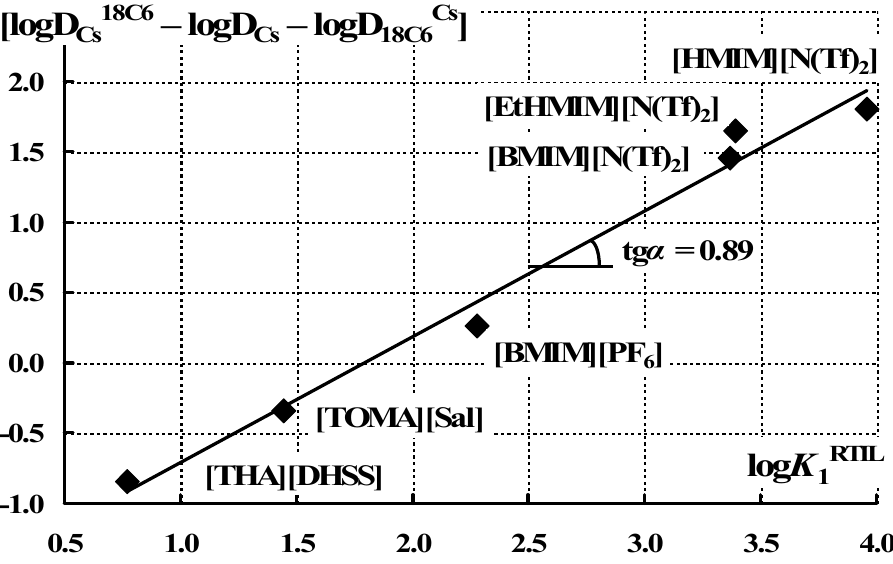
Figure 3. A plot of [logD Cs18C6 − logD